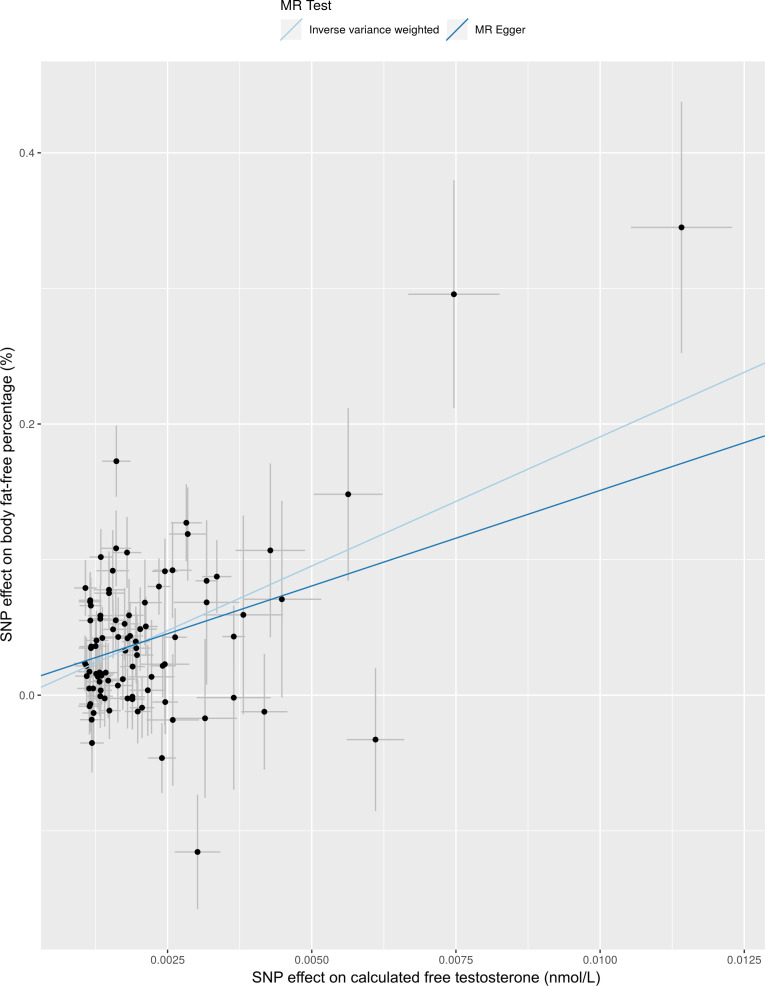
Comparison of effect of calculated free testosterone on body fat-free percentage using Mendelian randomization with IVW and Egger regression methods.